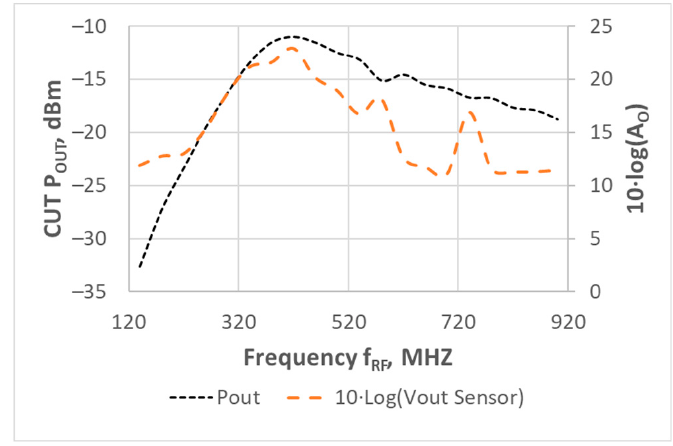
Figure 13. Sensor’s output measured with the DMM, superposed to power delivered to the load at the frequency (f RF + Δ f/2) as a function of f RF . Δ f = 1 kHz, and total PA input power = − 20 dBm ( − 23 dBm/tone). Sensor output voltage represented as in [33] .